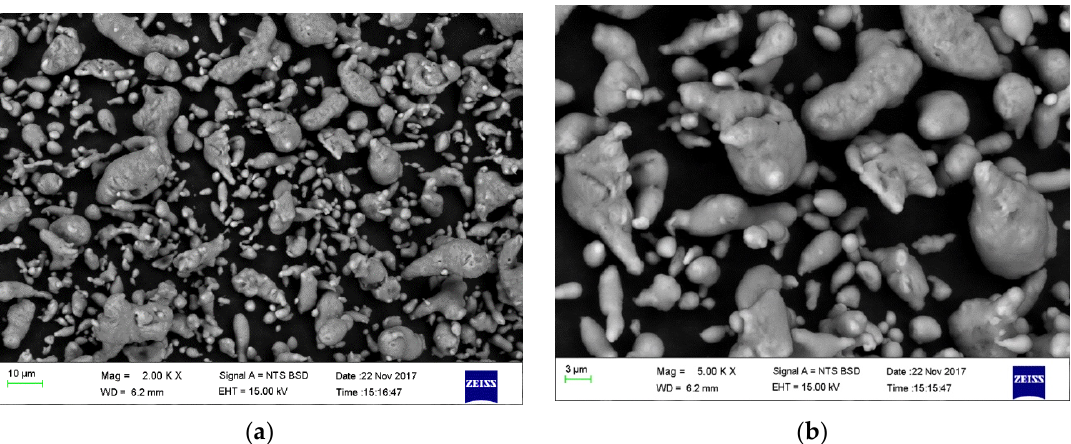
Figure 2. Scanning electron microscope (SEM) backscattered electron micrographs of the Al 2 O 3 –SiC composite powder at: ( a ) low; ( b ) high magnification.